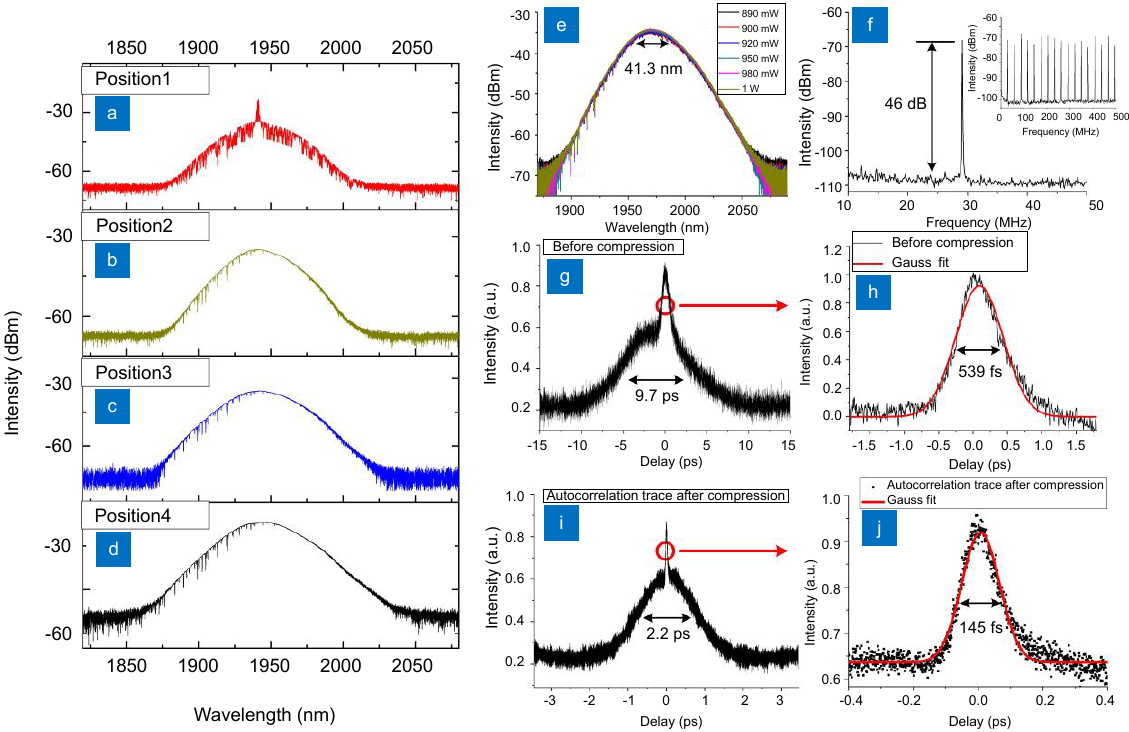
Fig. 4 | Performance of noise-like pulses. ( a ) – ( d ) Spectra evolution process of noise-like pulse. ( e ) Spectra with different pump power. ( f ) RF spectra. ( g ) Integrated autocorrelation trace before compression. ( h ) Peak autocorrelation trace before compression (at point a in Fig. 1). ( i ) Inte- grated autocorrelation trace after compression (at point c in Fig. 1). ( j ) Peak autocorrelation trace after compression (at point c in Fig.